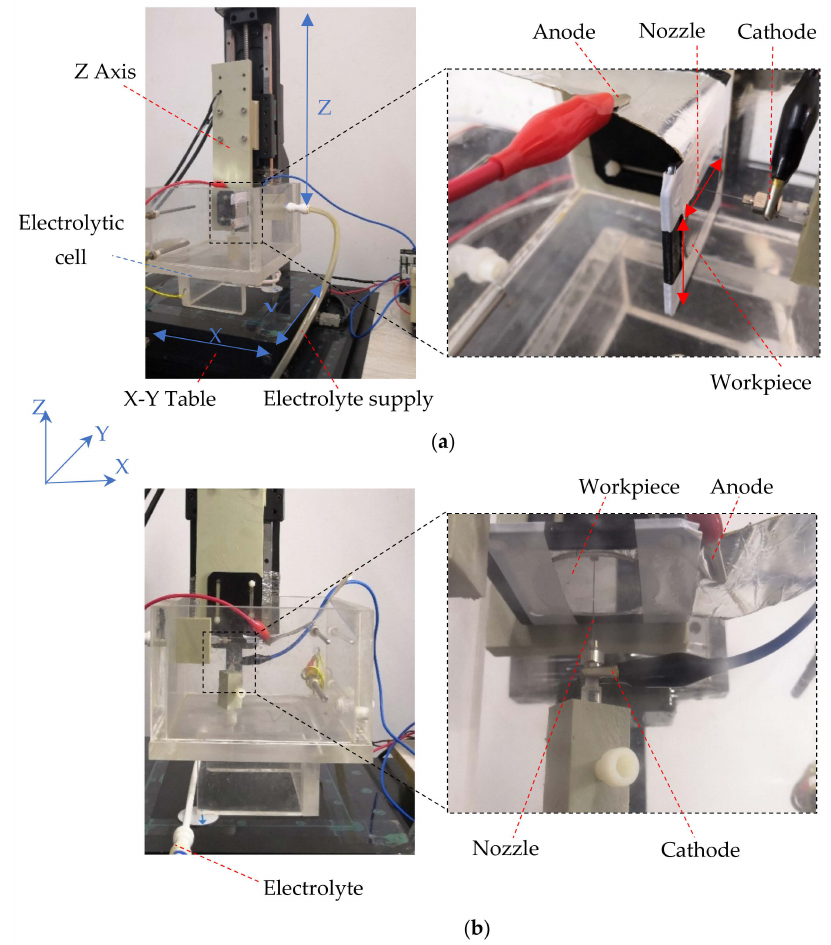
Figure 6. Jet electrochemical machining with di ff erent orientations. ( a ) Horizontal orientation; ( b ) vertically upstream